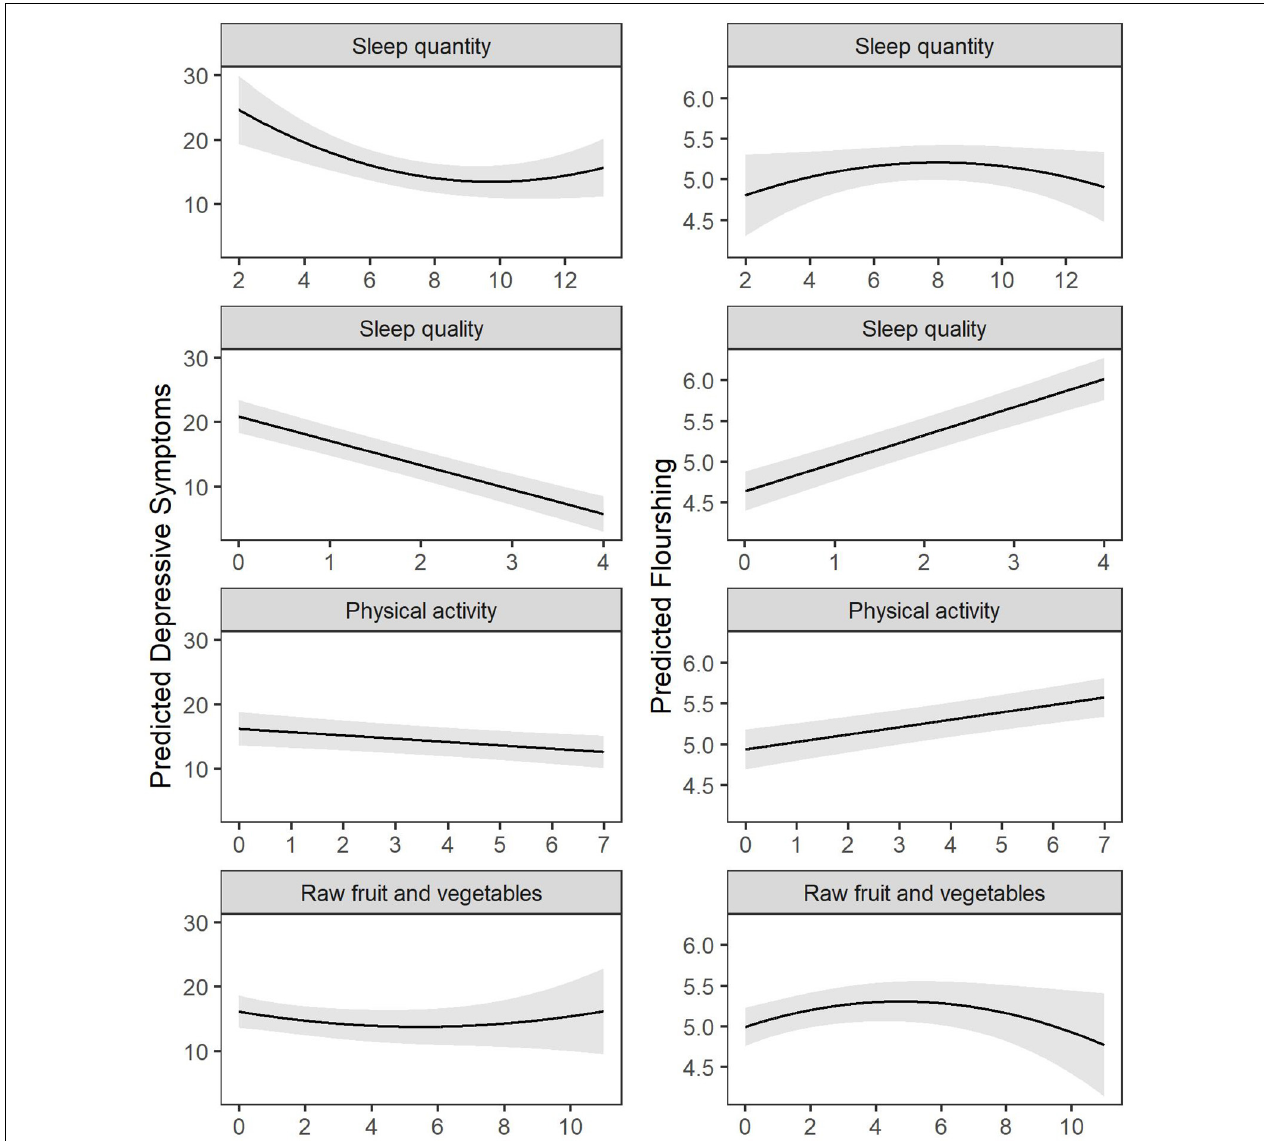
FIGURE 1 | Visualization of hierarchical regression model results predicting depressive symptoms and flourishing, adjusted for other health behaviors and covariates ( n =